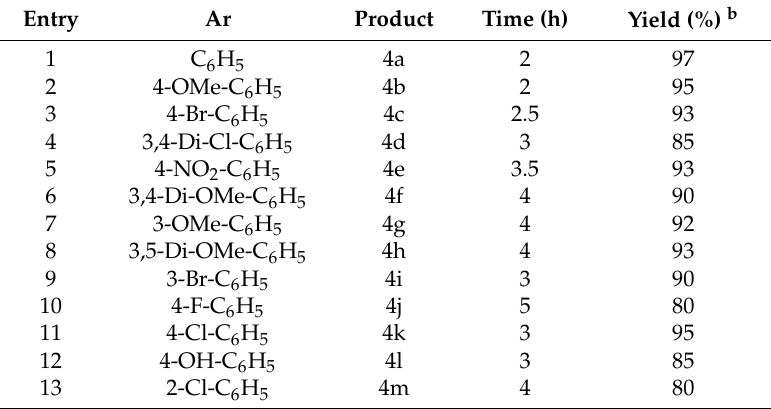
Table 2. Synthesis of chromene derivatives 4a–4m a using HUC